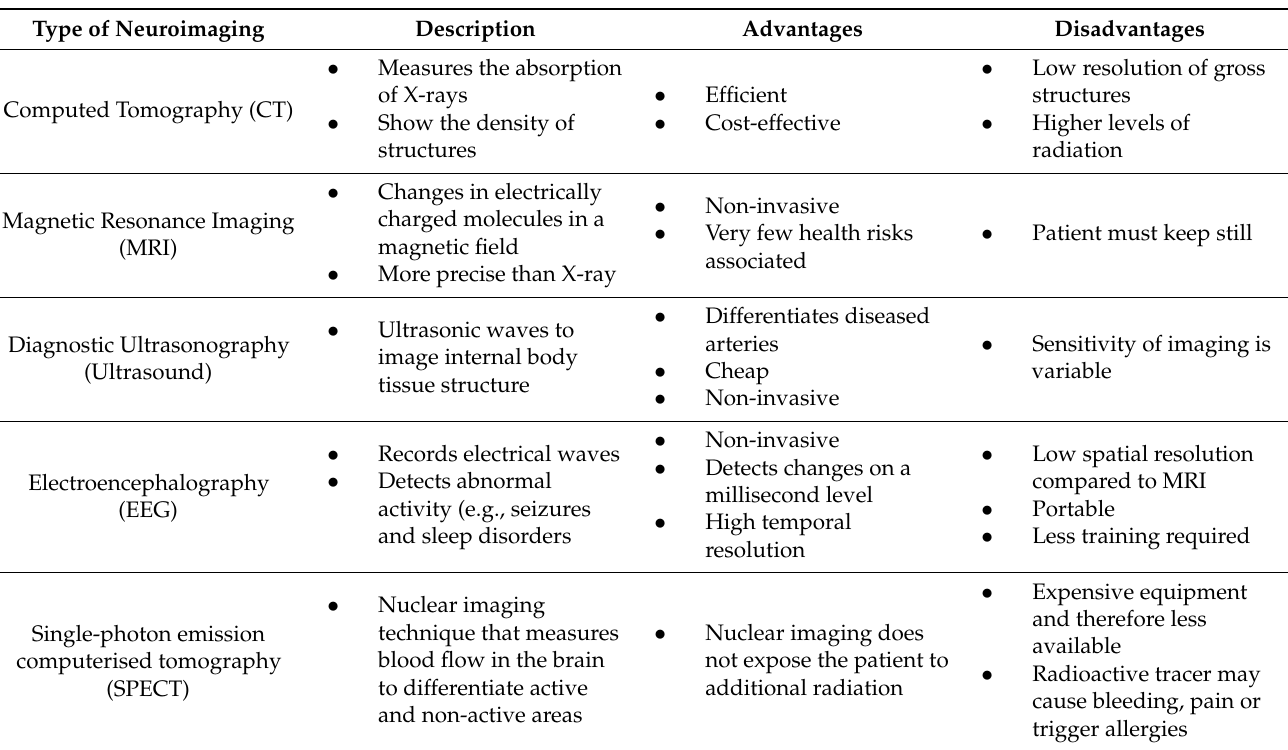
Table 2. Summary of diagnostic neuroimaging